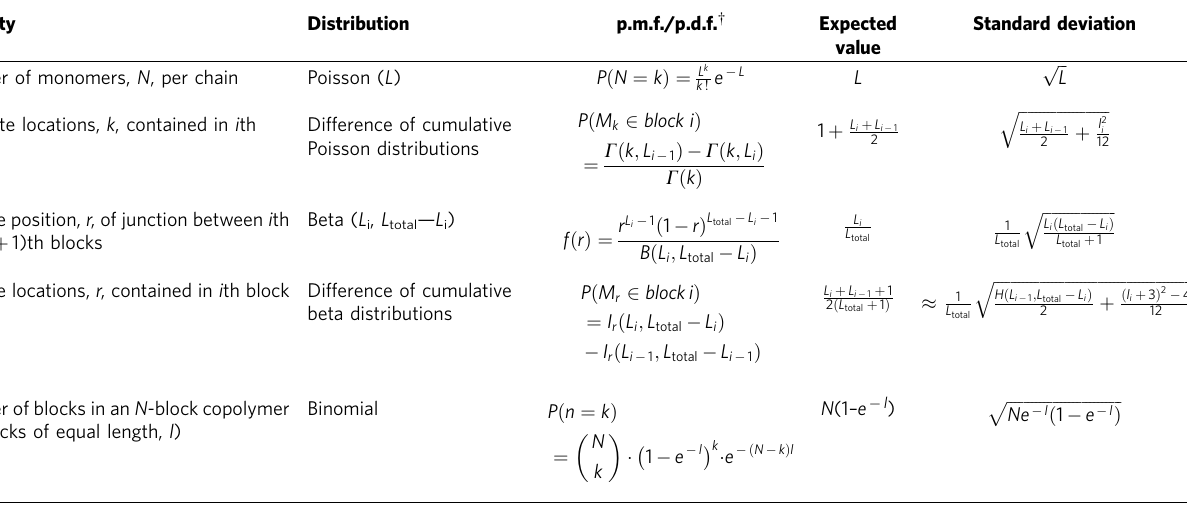
ffiffiffiffiffiffiffiffiffiffiffiffiffiffiffiffiffiffiffiffiffiffiffiffiffiffiffiffi Ne (cid:2) l 1 (cid:2) e (cid:2) l